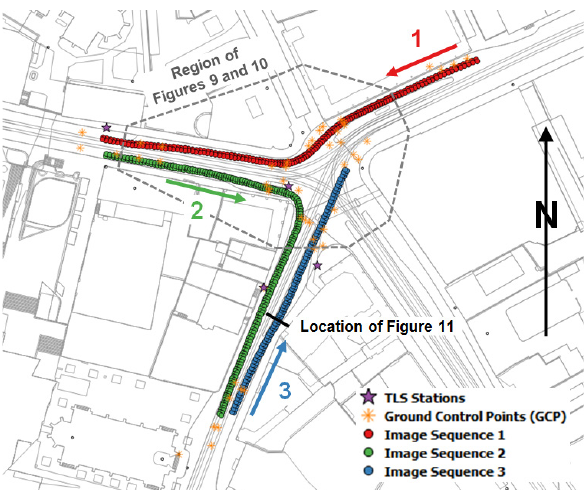
Figure 4. Base map of the test area with overlaid projection centers of the selected image sequences, GCP and TLS stations (Source: Geodaten Kanton